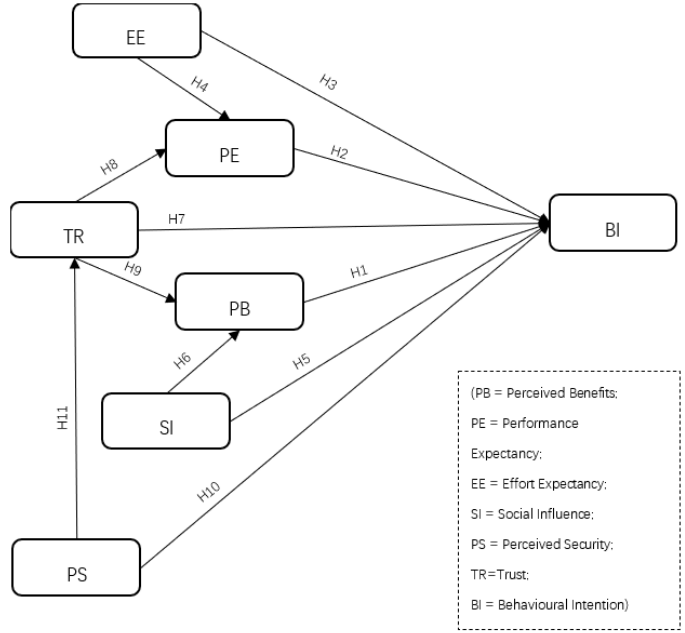
Figure 1. Research model with proposed hypotheses relations.